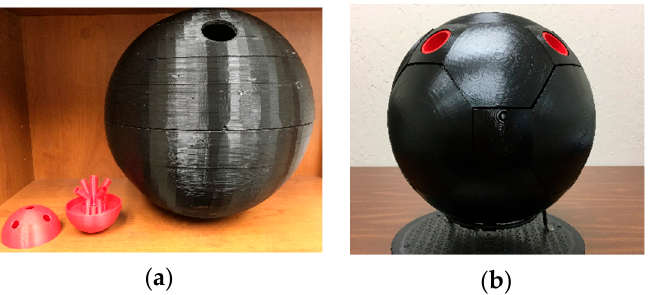
Figure 9. Hemispheric and plated spherical hulls ( a ) Initial 1/4-scale model and full-scale, hemi- spheric hull prototypes ( b ) Plated hull configuration.